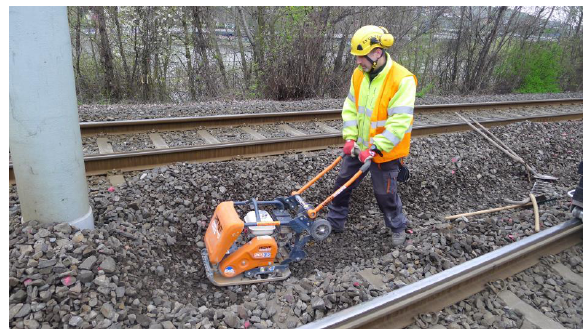
Figure 6. Compaction of groove surface prior to the screen placement.